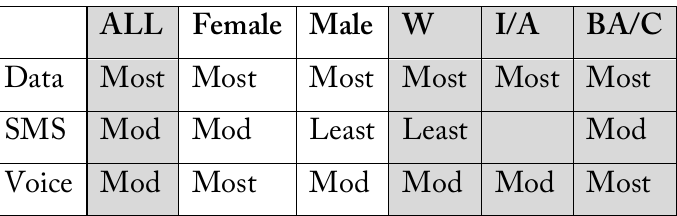
Table 3: Data vs SMS vs